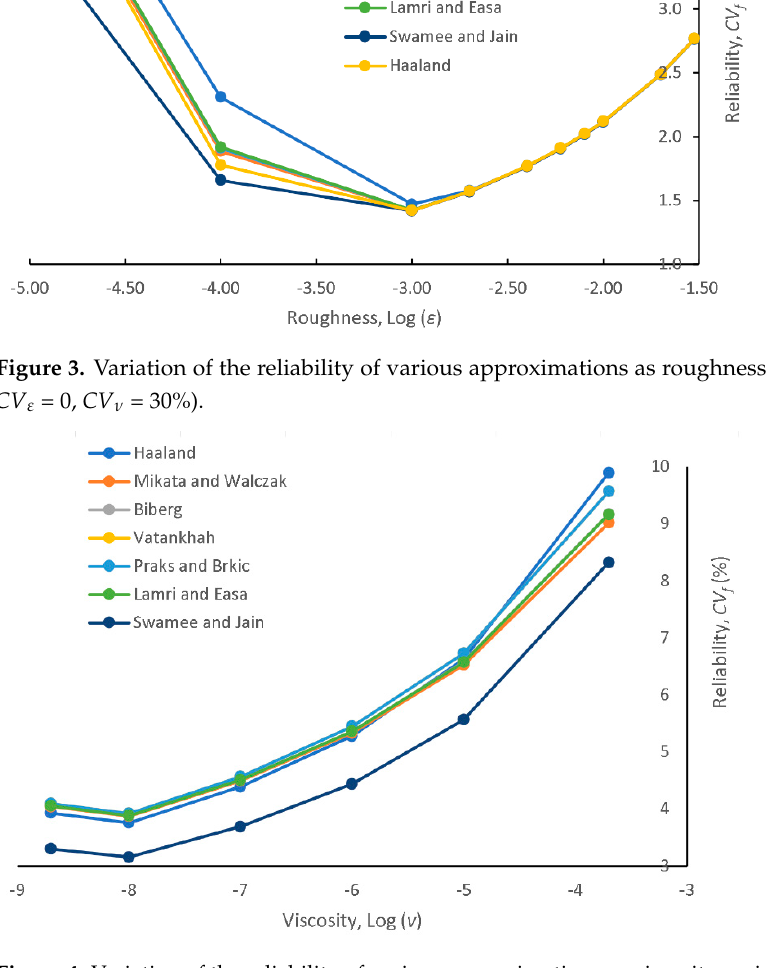
Figure 4. Variation of the reliability of various approximations as viscosity varies for the smooth-flow regime ( ε = 0).